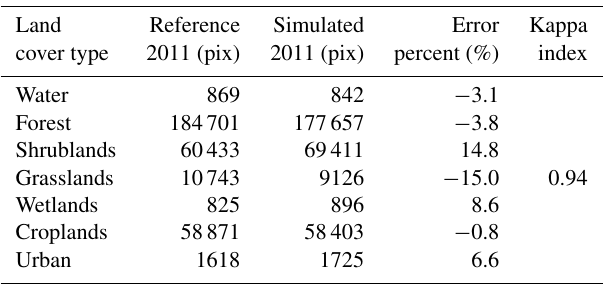
Table 2. Difference between the reference map of 2011 and the simulated map 2011.